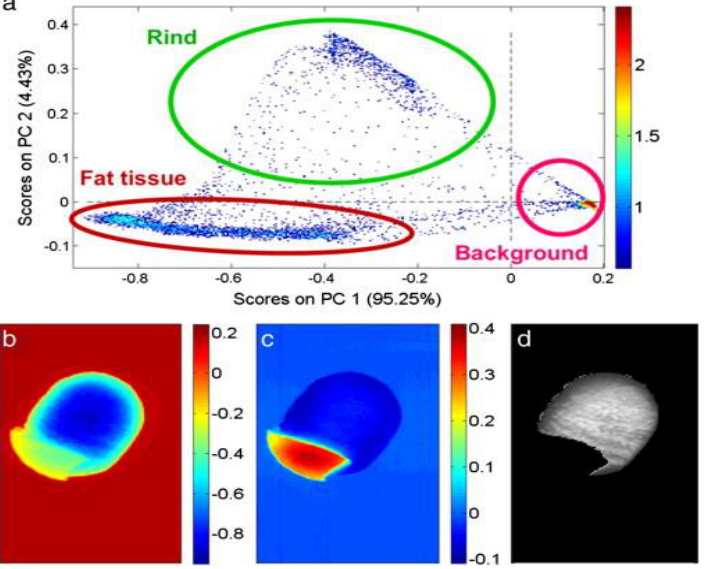
Figure 2. Classification of pork sample from the into rind, adipose tissue, and background ( a ); The background ( b ) and fat tissue ( c ) pixels. ( d ) is the gray image of the pork sample [82].